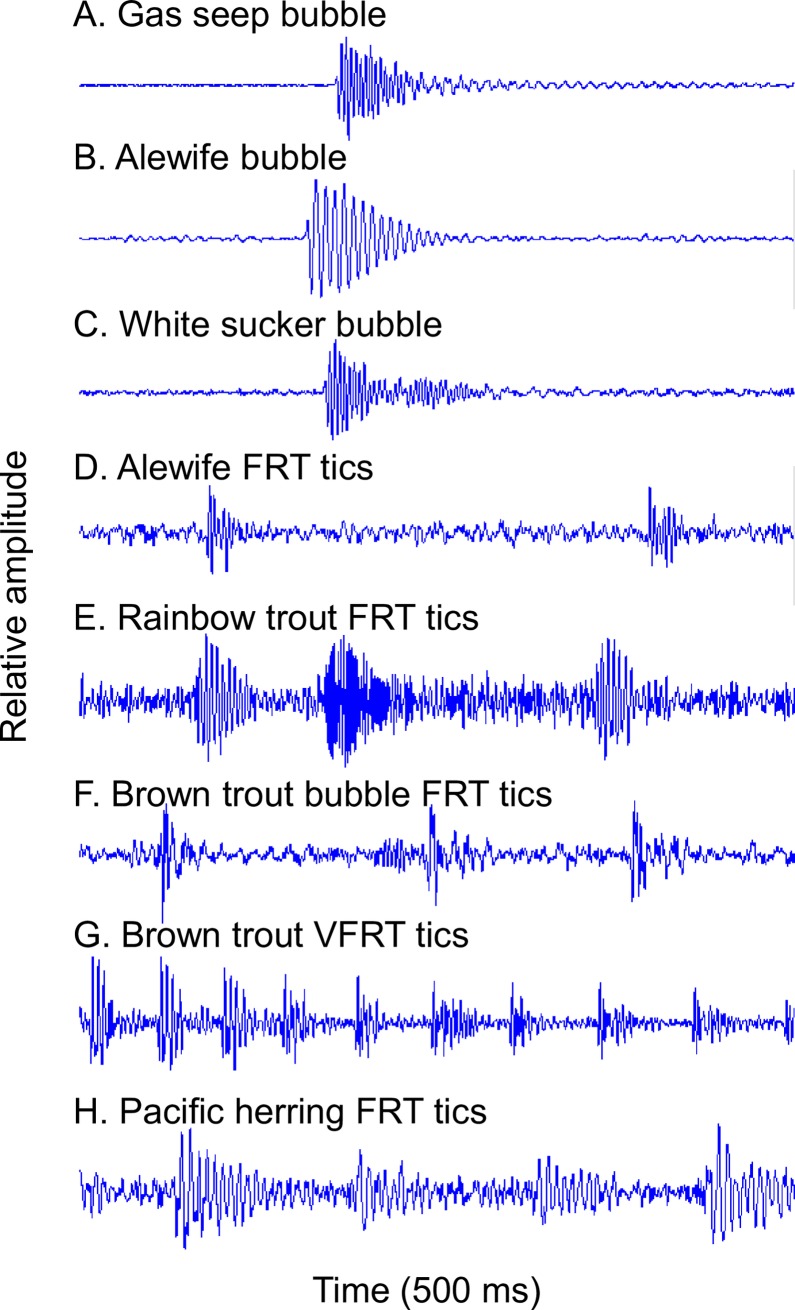
Comparison to bubble sounds.Waveforms of individual air bubble sounds, and individual FRT ticks are compared on the same 500 ms time scale after filtering around 500 Hz to 6000 Hz (amplitudes are relative and not directly comparable). (A) Single bubble from bottom sediment gas seep, (B) single bubble from alewife gills, (C) single bubble from white sucker, (D) two ticks from an alewife FRT, (E) three ticks from a rainbow trout FRT, (F) three ticks from a brown trout bubble FRT, (G) multiple ticks from a brown trout VFRT, and (H) four ticks from a Pacific herring FRT.